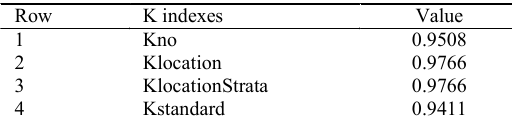
Table 5: Validation of projected 2014 land-use map with actual 2014 land-use map